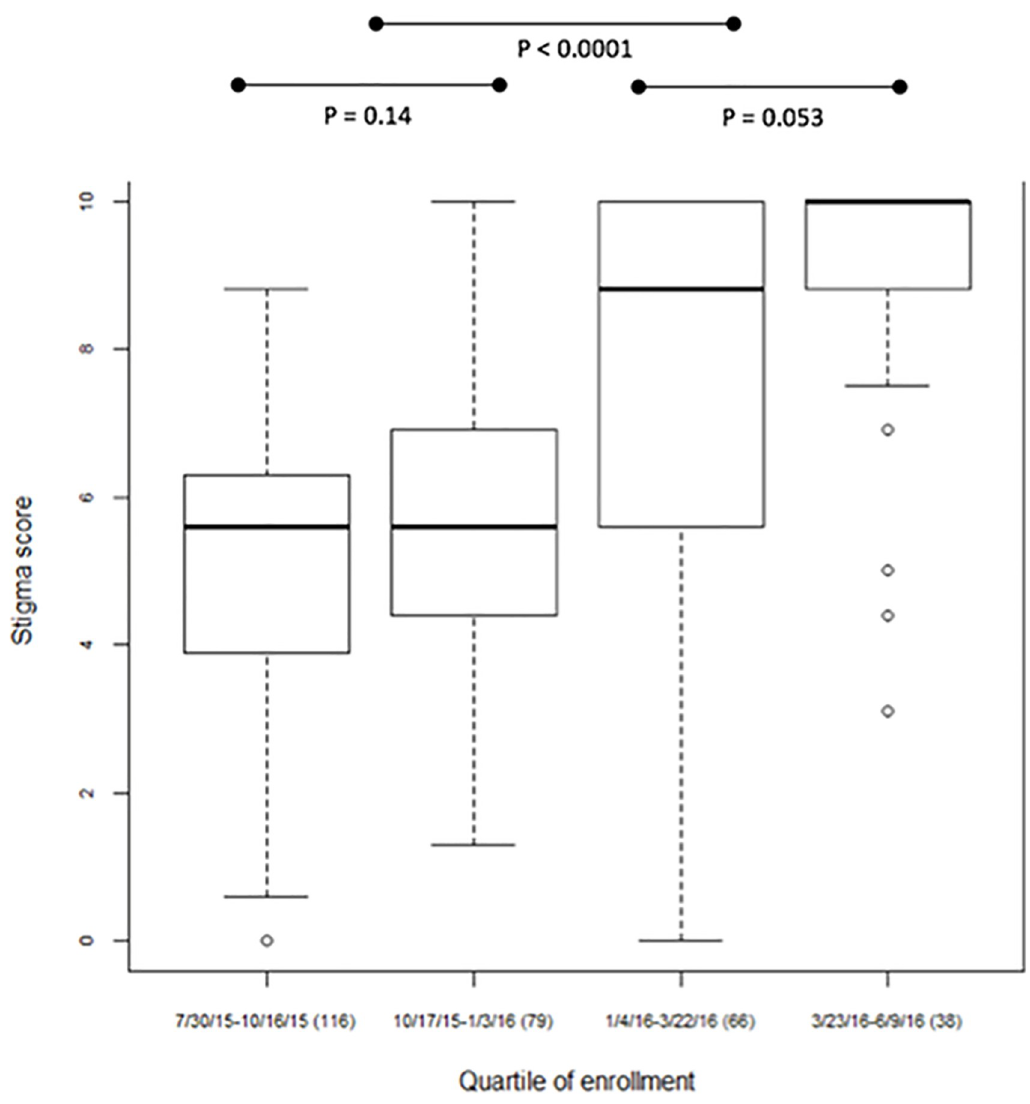
Fig 3. Trend in baseline total stigma scores over time. Fig 3: Comparison in baseline stigma scores of participants enrolled in the different quartiles of enrollment. X-axis labels are the date range for each quartile of enrollment followed by the number of participants recruited in the quartile in